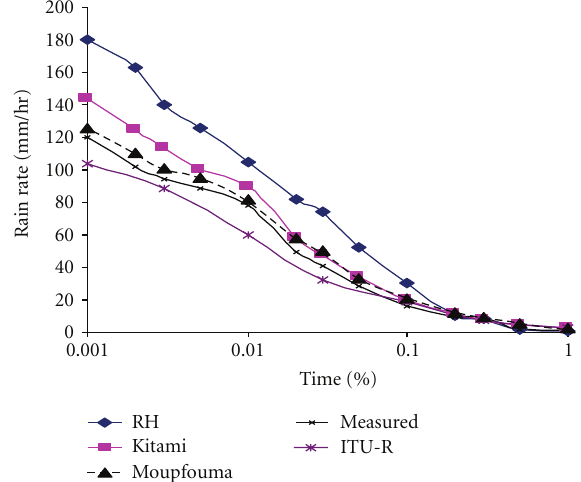
Figure 4: Comparison of measured UNIYOLA rainfall data with model